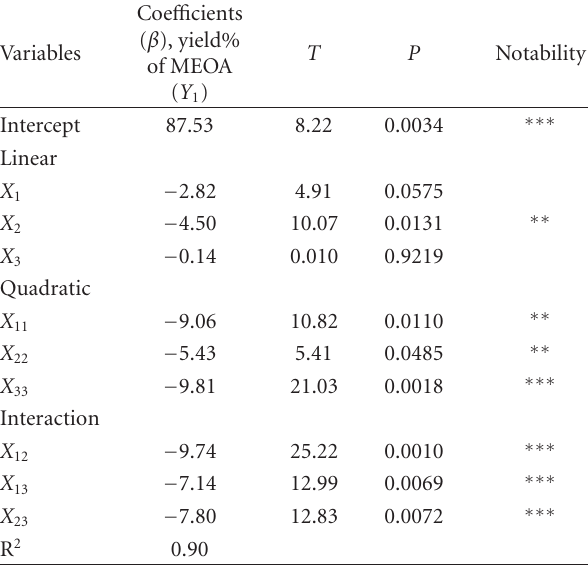
Table 4: Regression coe ffi cients of the predicted quadratic polyno- mial model for response variables of the OOC% for the